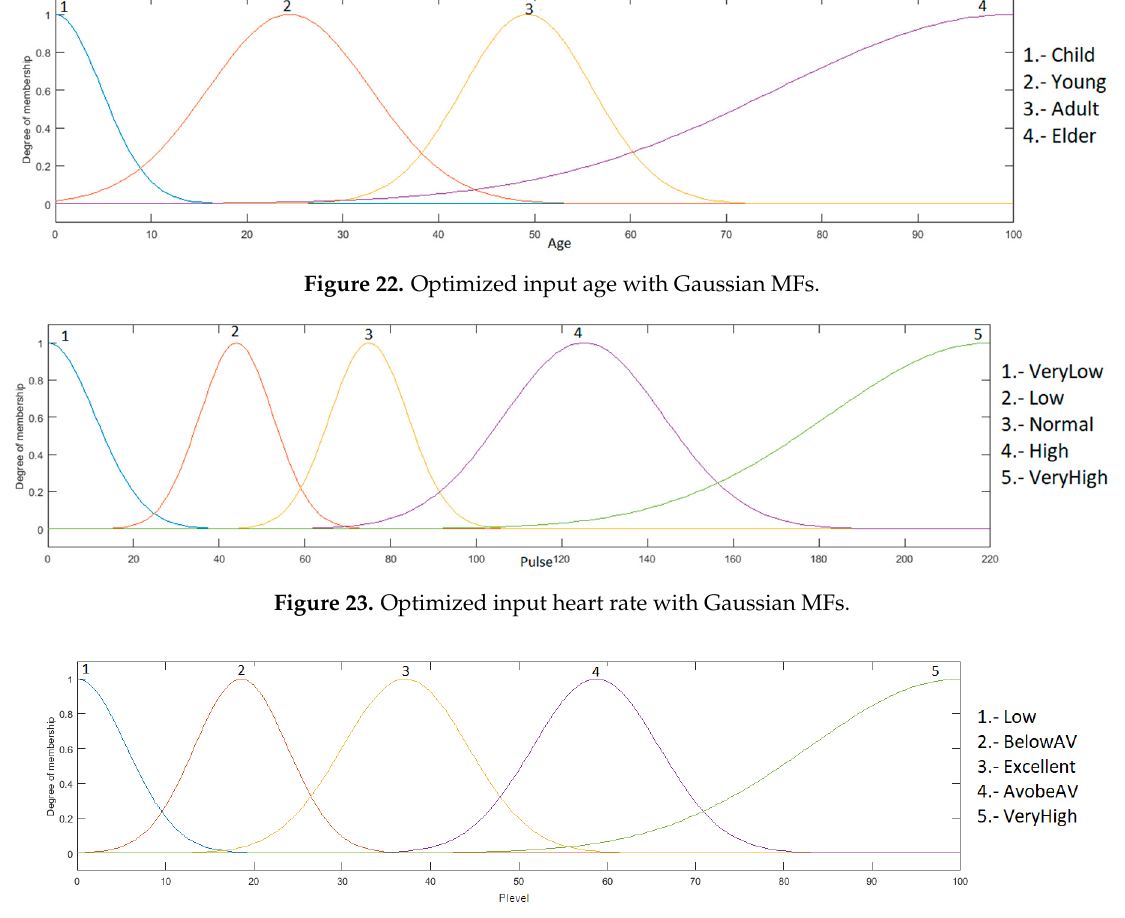
Figure 24. Optimized output heart rate level with Gaussian